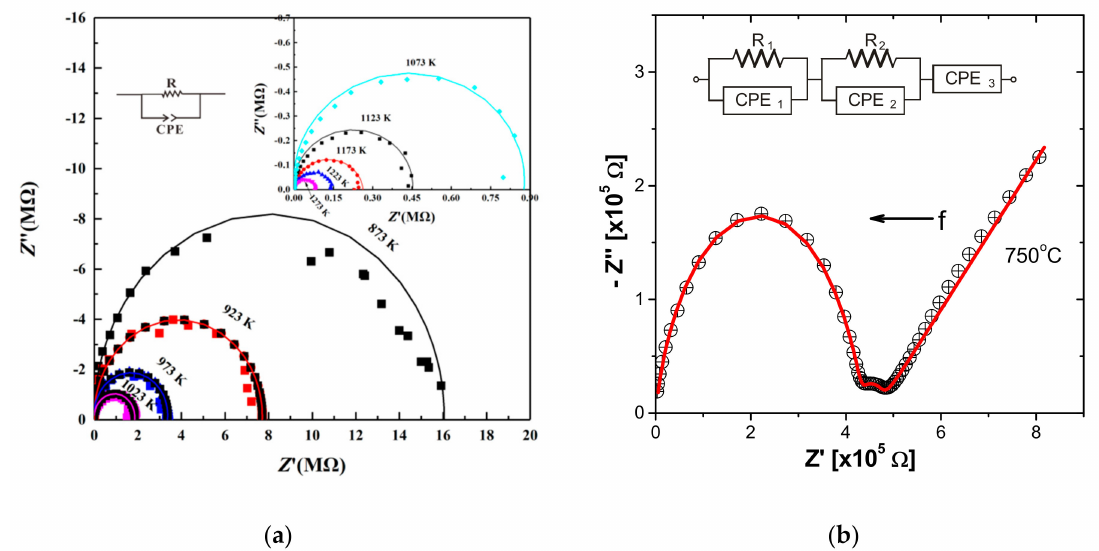
Figure 1. Cole-Cole plots of impedance ( − Z” vs. Z’ ) at two di ff erent cases. Solid colored lines represent the fitting of experimental data to an equivalent circuit. ( a ) Dry olivine aggregates measured at elevated temperatures (873–1273 K) and pressure of 2 GPa [52]. ( b ) Diatomite sample measured at 750 ◦ C, in the frequency range 10 − 2 –10 6 Hz. The contributions of grains interior, grain boundaries and electrode e ff ects are clearly shown as two depressed semicircles accompanied with a tail in the low frequency range. The equivalent circuit is also shown (data from